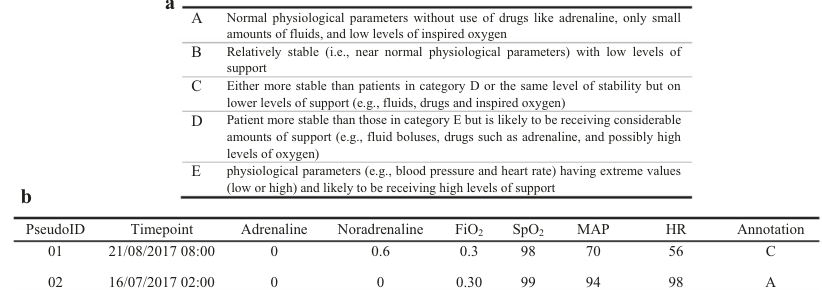
Fig. 1 Description of the QEUH annotated training data. a ICU-PSS annotation categories. b Example instances of a QEUH ICU annotated